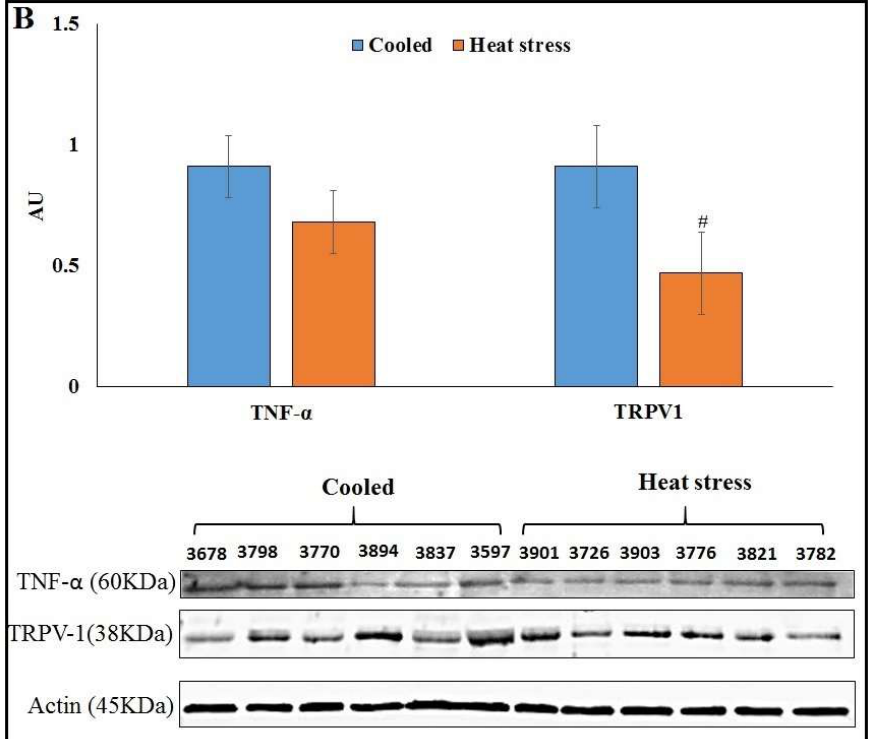
Figure 2. Protein abundance of ECS components in AT of late lactation cooled ( n = 6) or heat-stressed cows ( n = 6). ( A ) Presented are the average abundances of CB1, FAAH, MGLL and PPAR- α and immunoblots. ( B ) Protein abundance of TNF- α and TRPV1 in AT of late lactation cooled ( n = 6) or heat-stressed cows ( n = 6). * Significant with p ≤ 0.05. # Statistical tendency with p = 0.1.